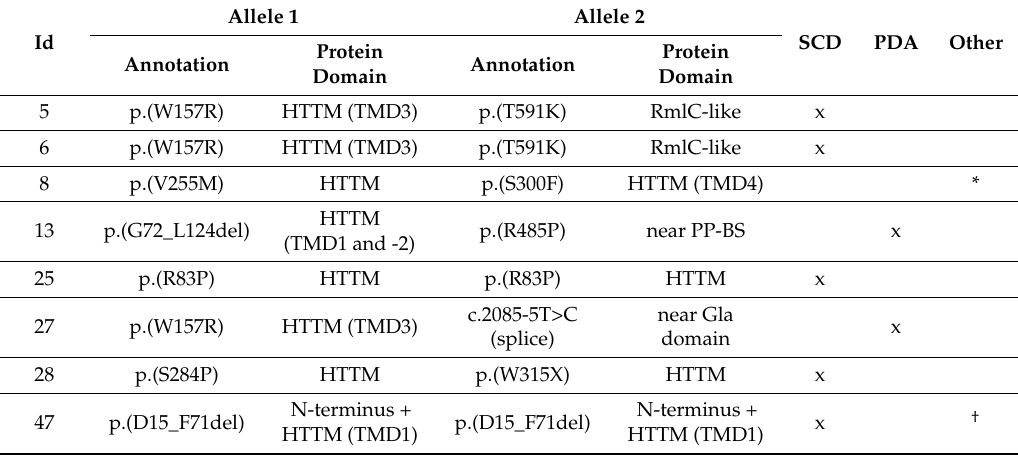
Table 4. Cardiac involvement in patients with GGCX mutations. This table gives an overview of all patients in the analyzed cohort with cardiac involvement. For each patient, the GGCX mutations on both alleles and the affected protein domain are stated (protein annotation). Further, a brief overview of the cardiac symptoms is